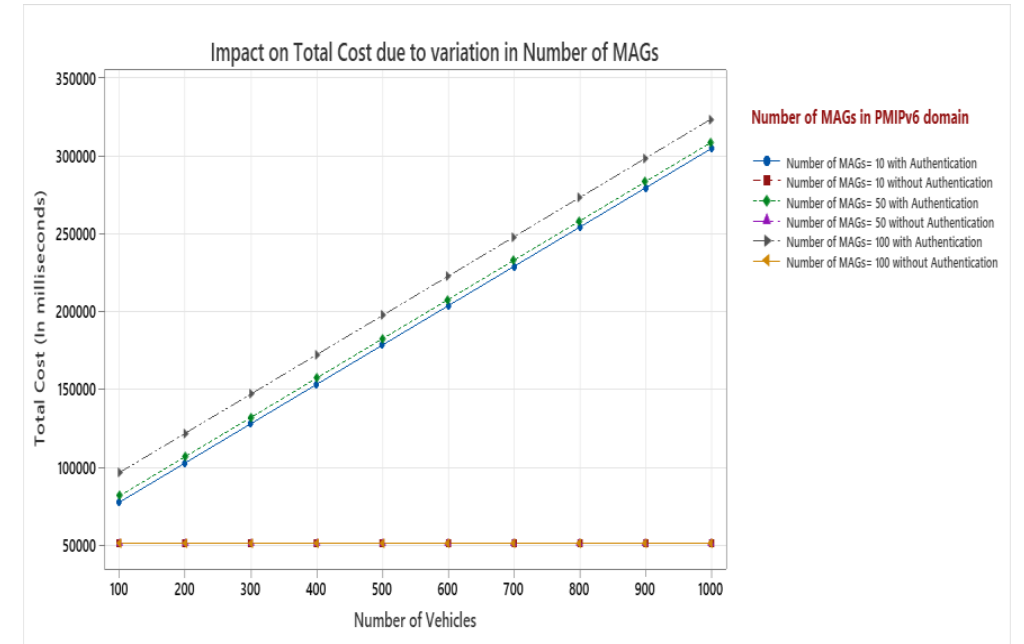
Figure 10. Impact on total cost due to variation in binding update cost.